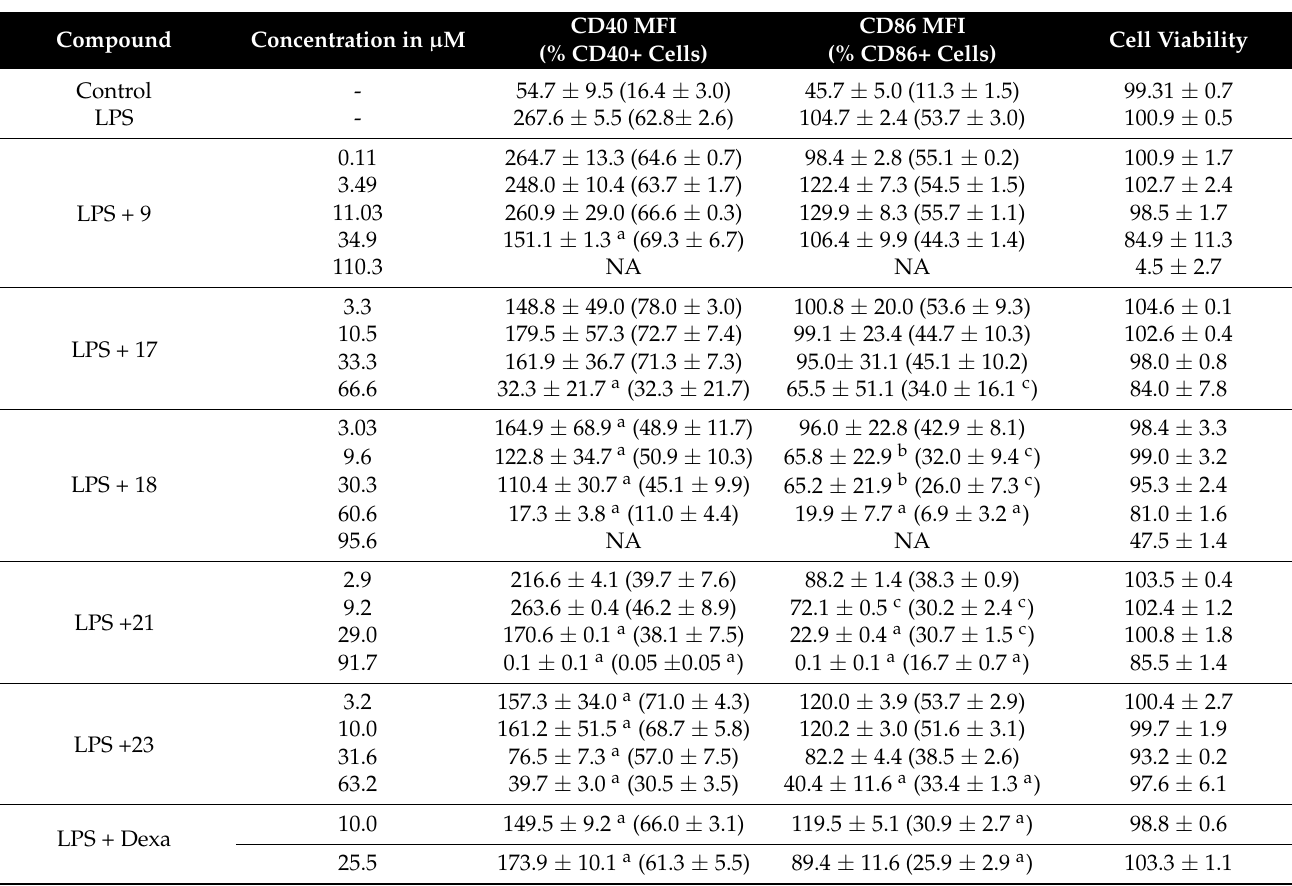
Table 2. Effect of selected semisynthetic abietane diterpenoids on co-stimulatory molecule expression in